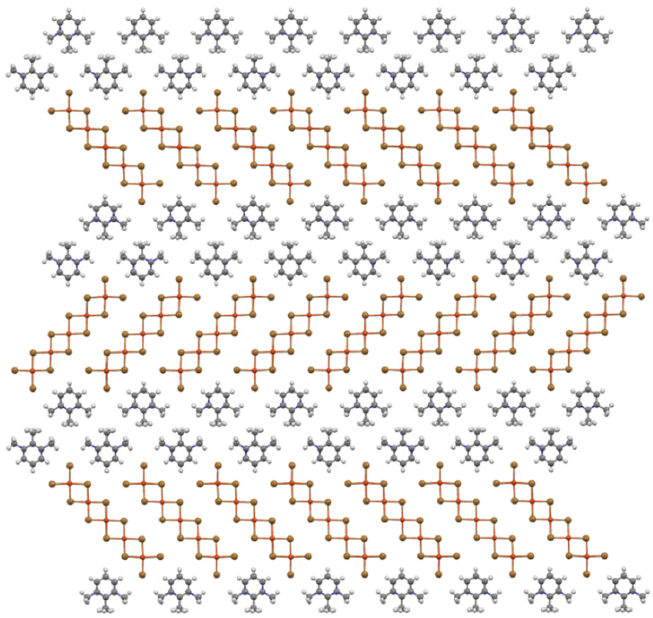
Figure 6. Ball-and-stick diagram of the mixed cation/oligomer sheets viewed perpendicular to the (302) plane with b horizontal.